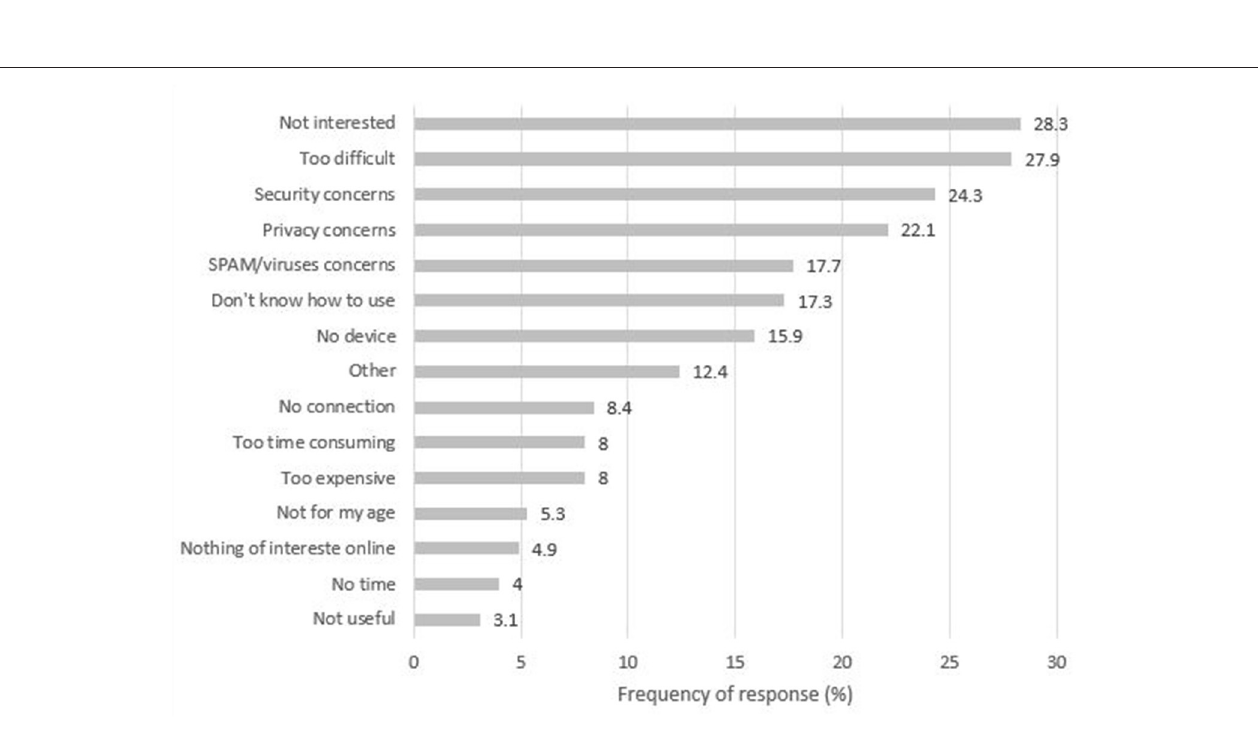
be explained, up to an extent, by prices in mobile data falling steeply lately